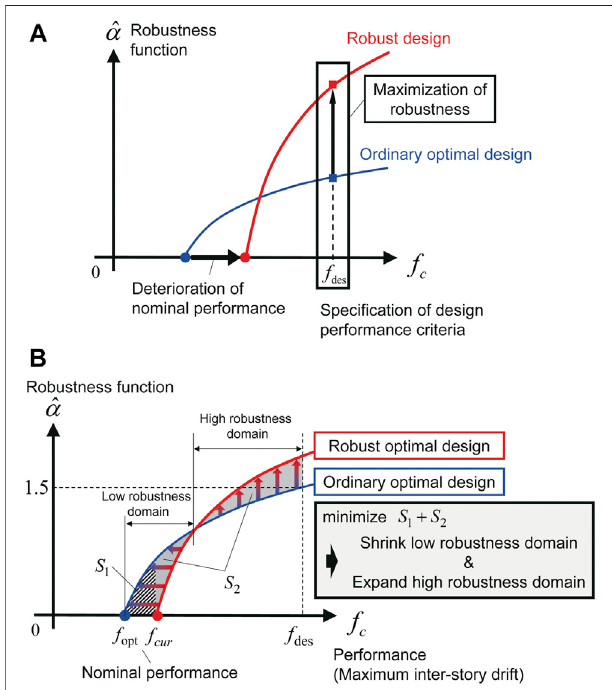
FIGURE 3 | Conventional and proposed robust optimization problems, (A) Conventional robust optimization problem: Maximization of robustness function, (B) Proposed robust optimization problem: Multi-objective optimization.